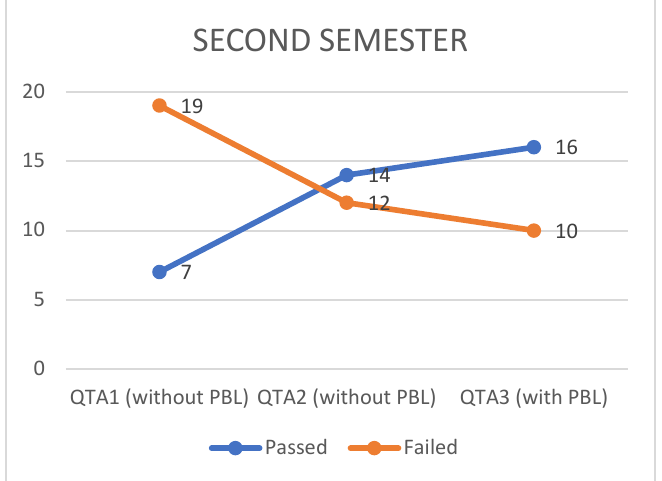
Fig. 6. Comparisons of PBL use in the second semester. Source: Author.